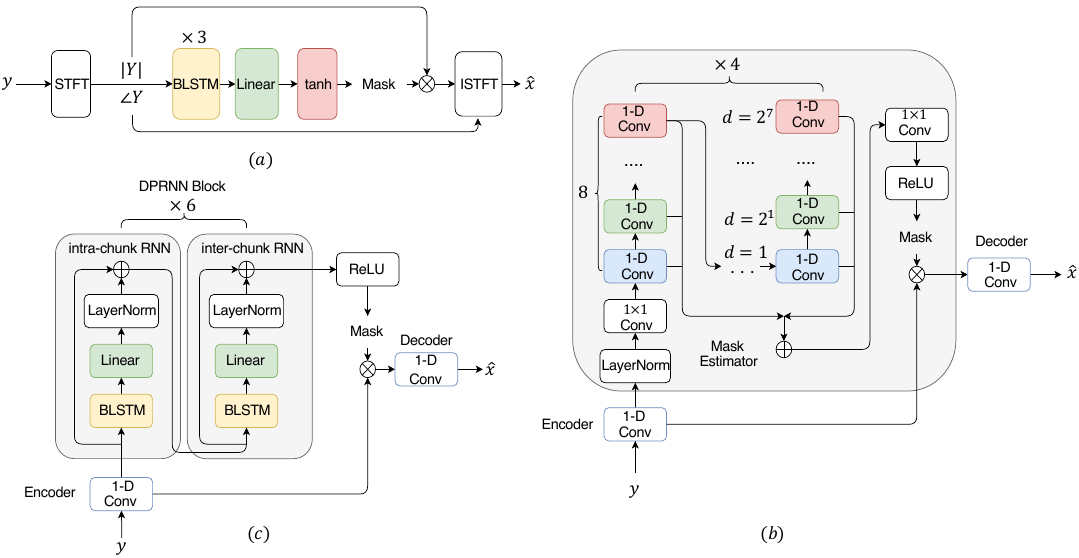
Figure 3. The diagrams of baseline models. ( a ) The diagram of LSTM model. ( b ) The diagram of the Conv-TasNet. ( c ) The diagram of the